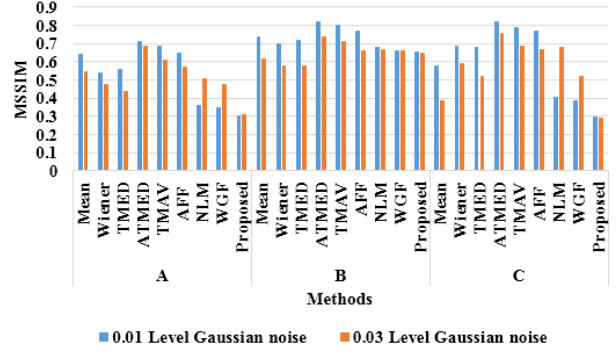
Figure 12: Graphical comparison of MSSIM value (0.01 and 0.03 Level Gaussian